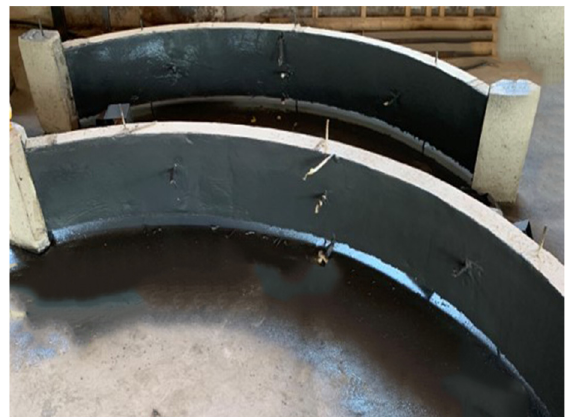
Figure 4. Polyurea ‐ reinforced arch structures.